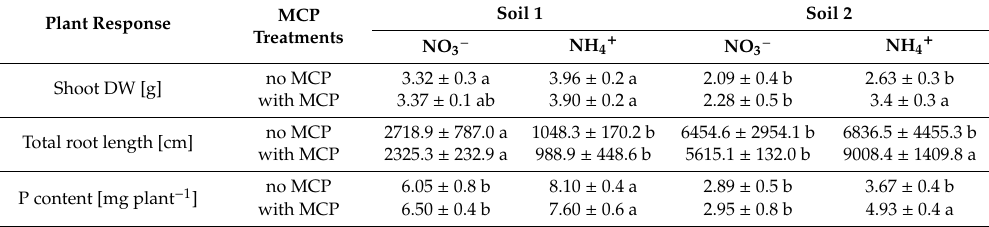
Table 1. Shoot dry weight, total root length and P content in shoot tissue of maize plants (cv. Jessy) on two low P soils. as a ff ected by MCP inoculation. Soil 1 (sandy-loam, pH 6.1, P CAL 7 mg kg − 1 soil) and Soil 2 (clay-loam, pH 5.9, P CAL 20 mg kg − 1 soil) receiving N fertilization in in form of Ca-nitrate (NO 3 − ) or DMPP-stabilized ammonium (NH 4 + ) and a moderate soluble P supply (30 mg P kg − 1 ).